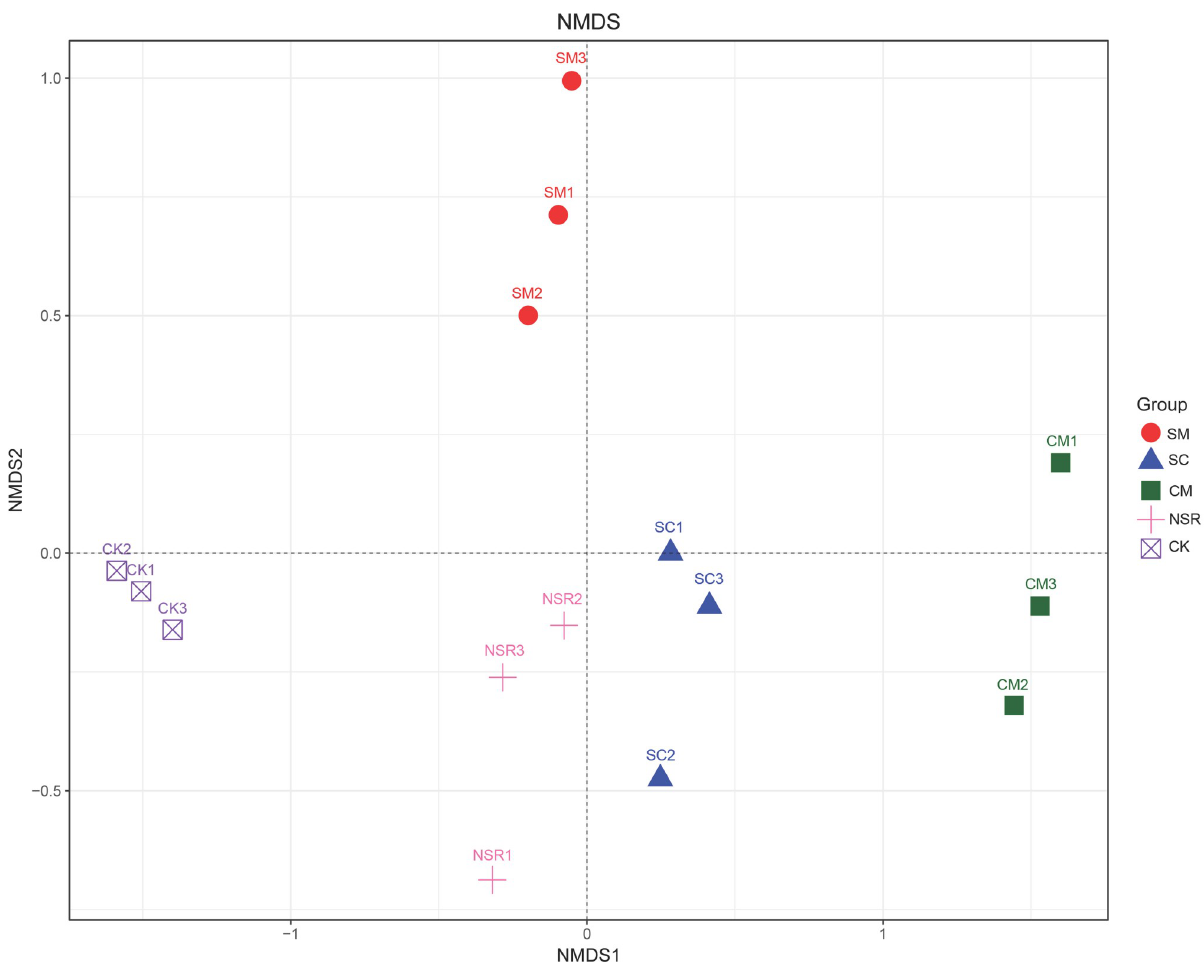
Fig 2. Nonmetric multidimensional scaling of the bacterial community compositions in soil under different treatments based on OTUs.